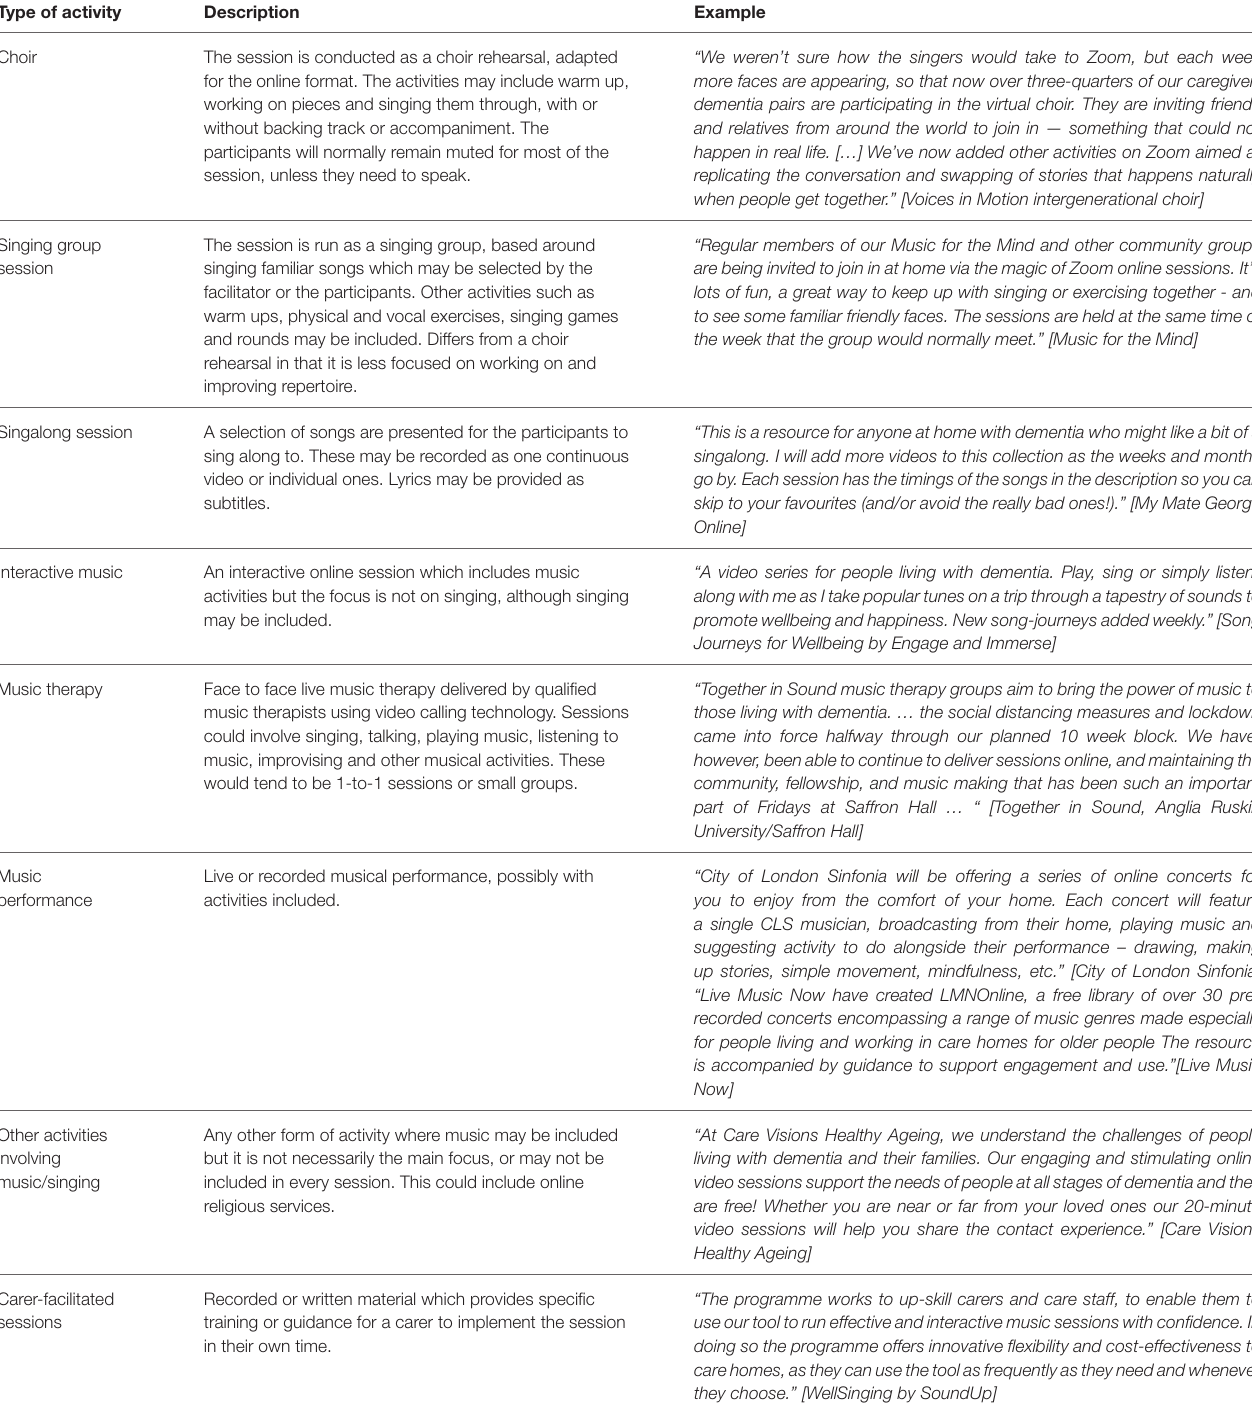
TABLE 2 | Types of online music making